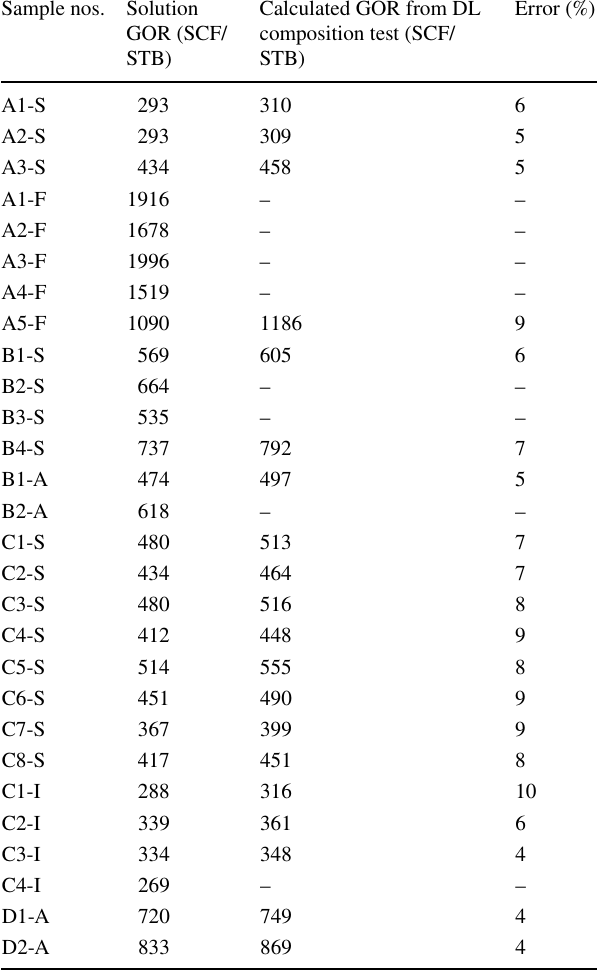
Table 4 Reported GOR and calculated GOR from compositional material balance of DL